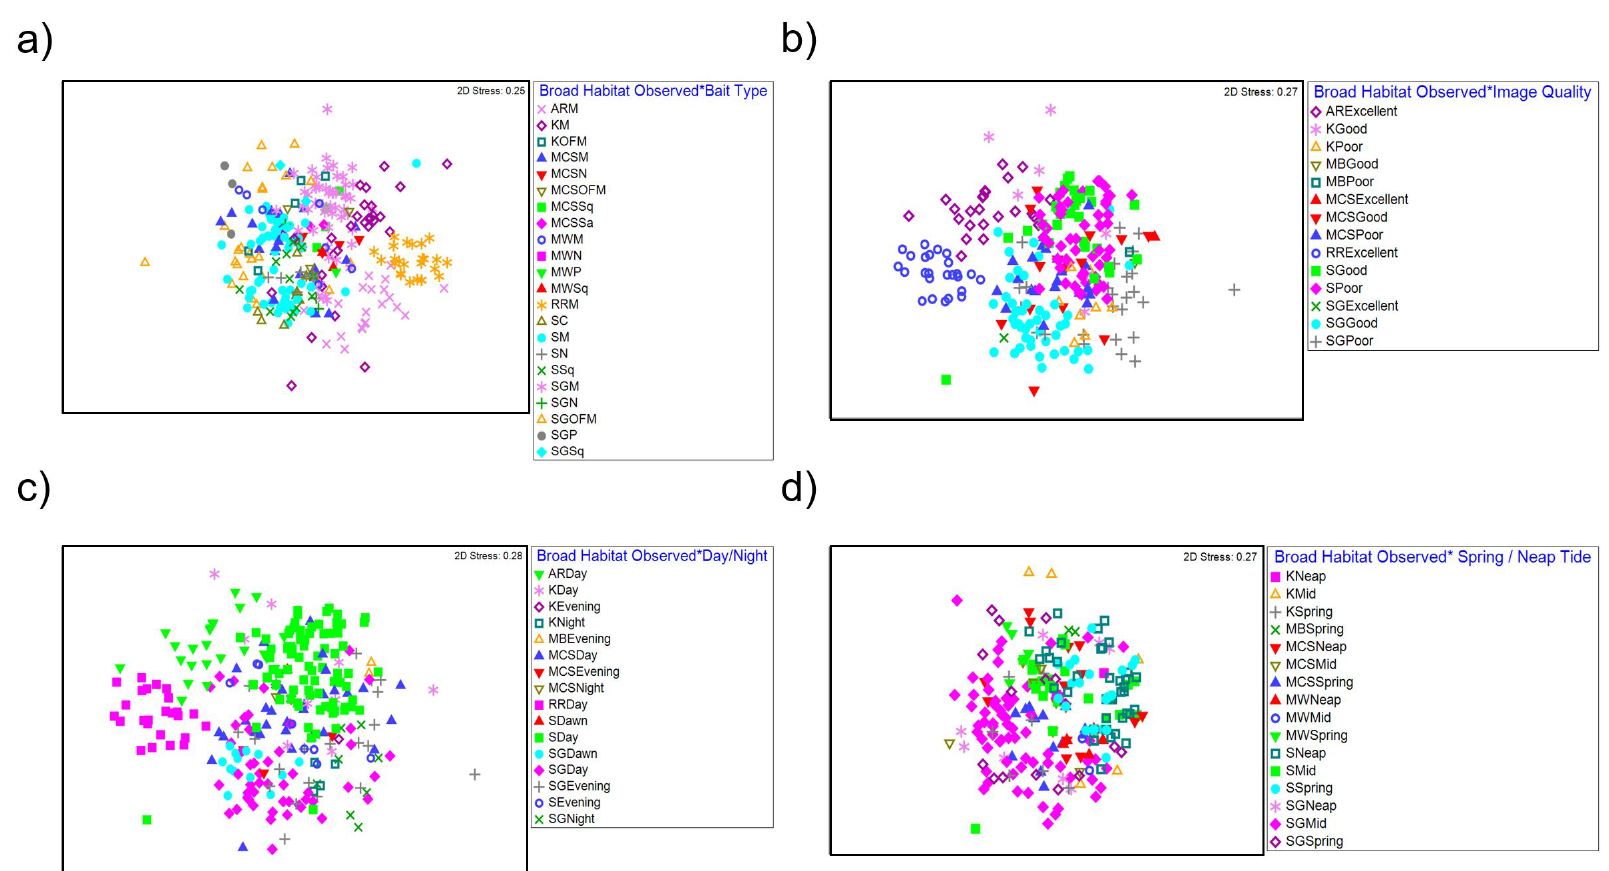
Figure 5. nMDS plot for interactions between ( a ) broad habitat observed and bait type, ( b ) broad habitat observed and image quality, ( c ) broad habitat observed and time of day, and ( d ) broad habitat observed and spring/neap tide. AR = Artificial Reef, K = Kelp, MCS = Mixed Coarse Sediment, MW = Midwater, RR = Rocky Reef, S = Sand, SG = Seagrass, C = Crab, M = Mackerel, OFM = Oily fish meal and fish oils, N = No bait, Sa = Sardines, Sq = Squid, and P =